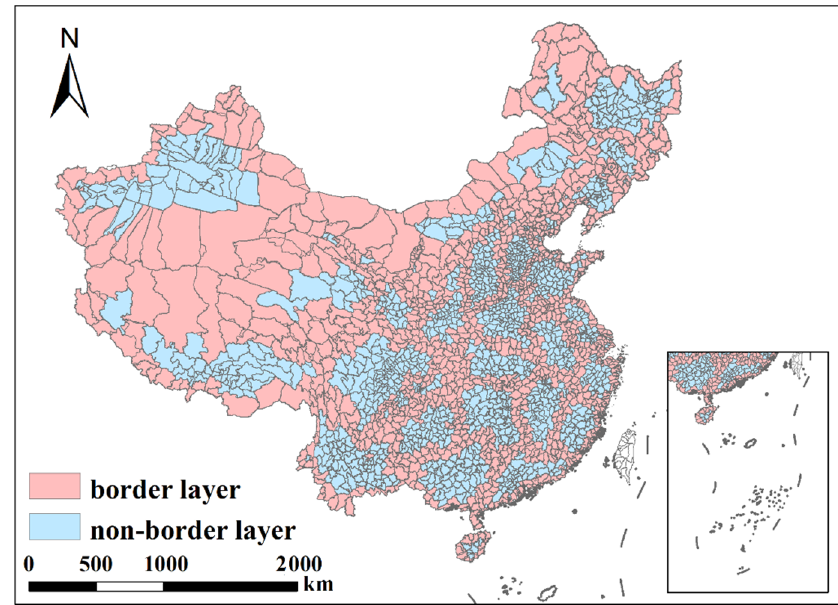
5 of 16 Table 1. Regional division of China. Region